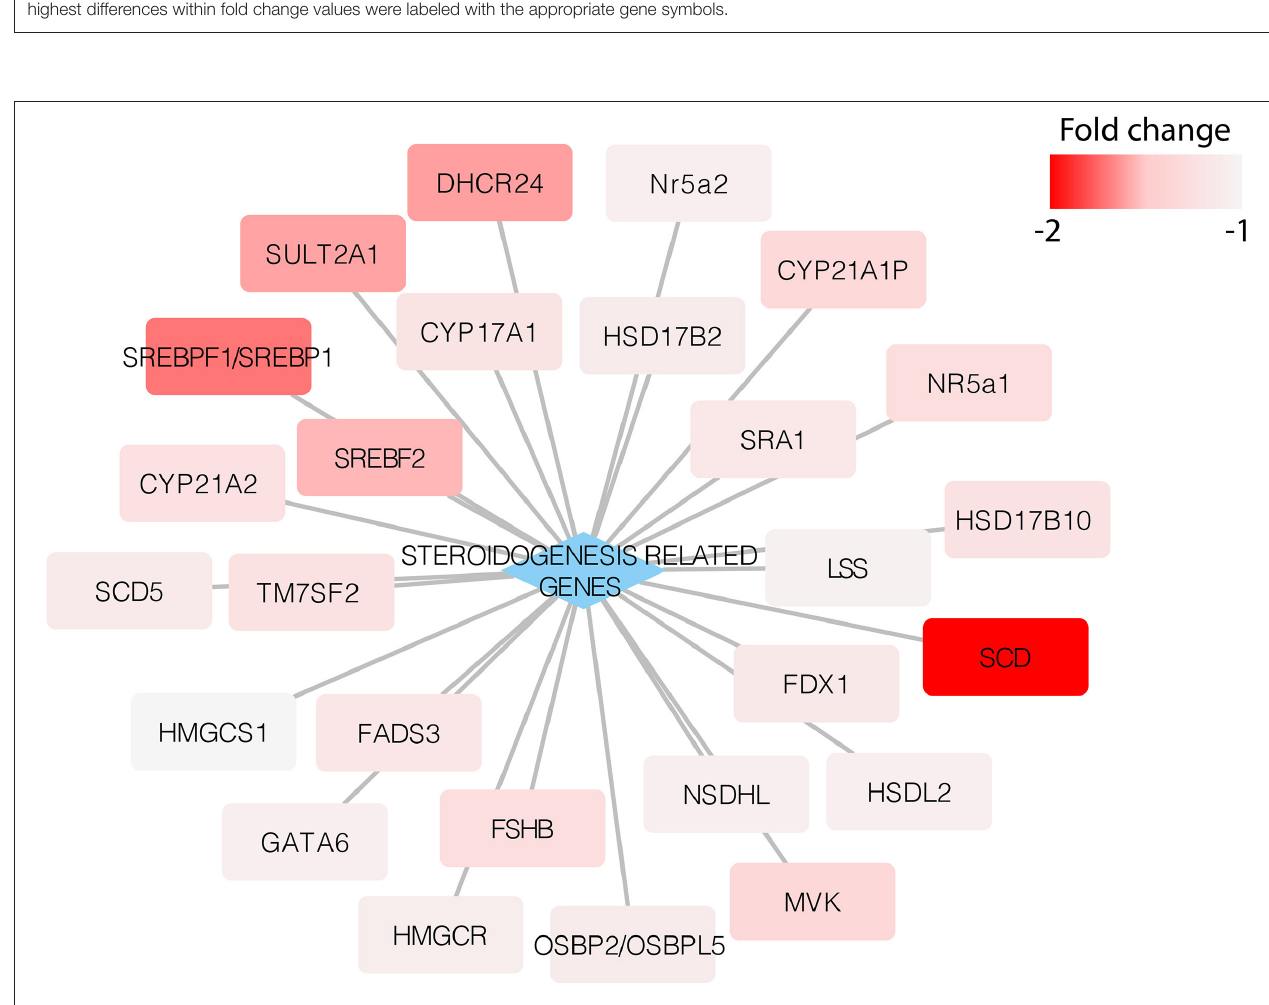
FIGURE 7 | Expression of steroidogenesis-related genes in the HAC15 cell line after 24h incubation with adropin compared to control (untreated) cells. Appropriate fold change values are marked in red.